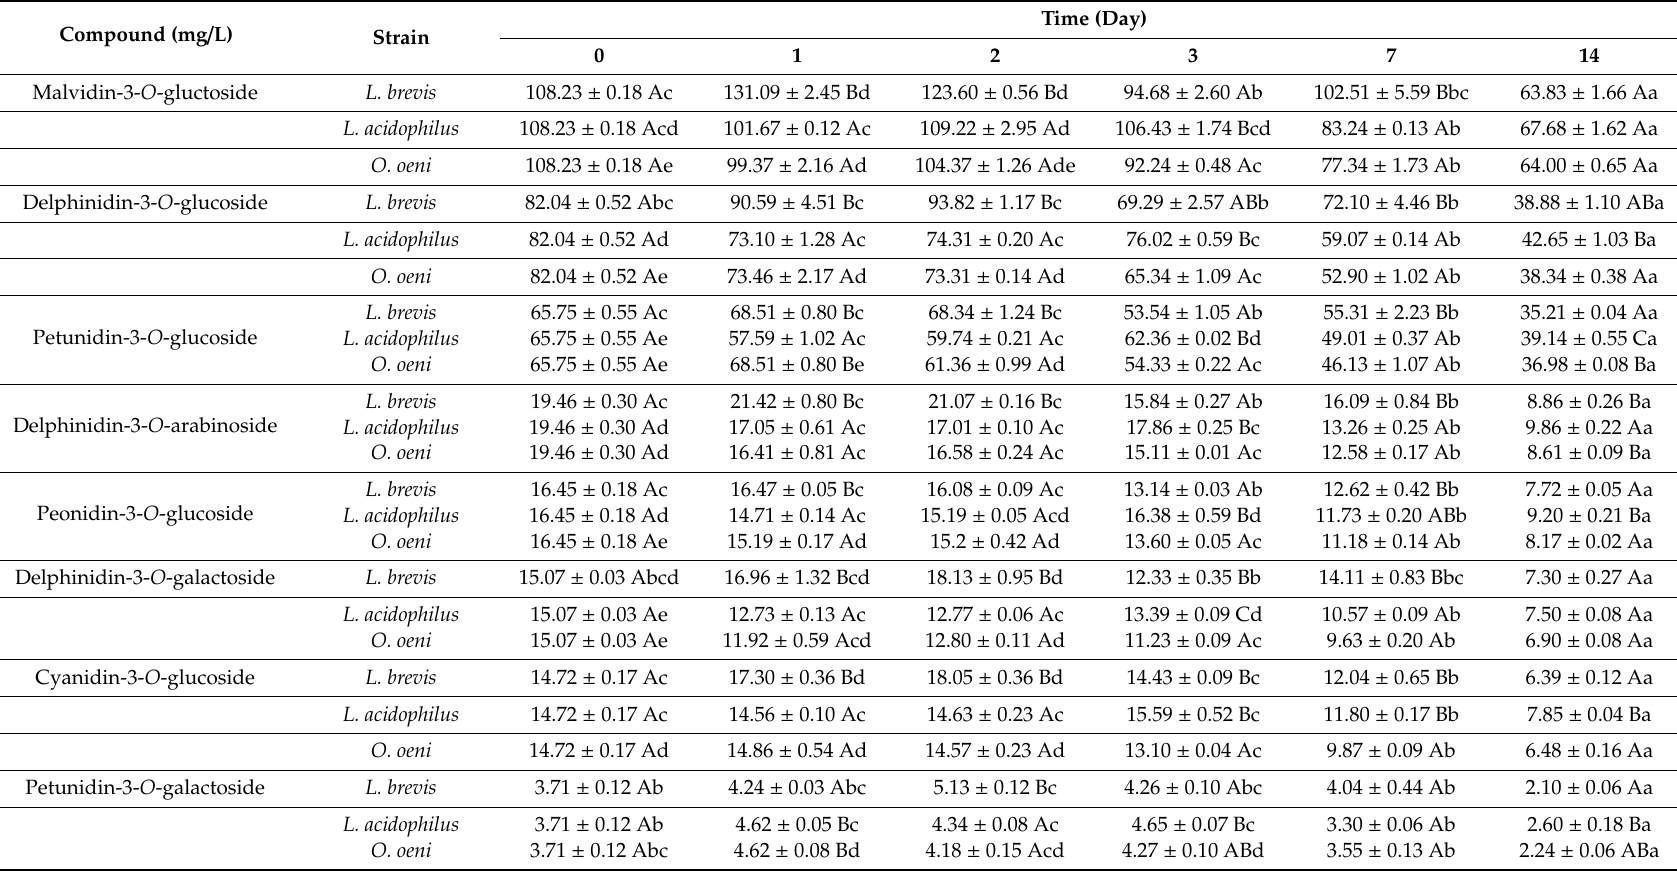
Table 1. Content of anthocyanins in bog bilberry juice inoculated with three lactic acid bacteria strains in 14